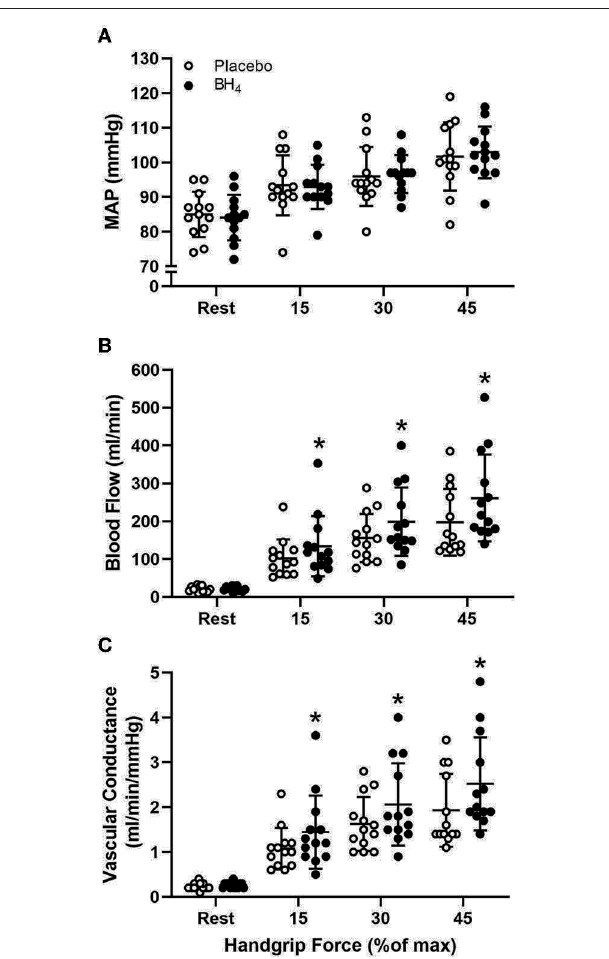
FIGURE 1 | Mean arterial pressure [MAP (A) ], brachial artery blood flow (B) , and brachial artery vascular conductance (C) at rest and during progressive handgrip exercise in patients with systemic sclerosis after placebo (white circles) and tetrahydrobiopterin (BH 4 ; black circles). * P < 0.05, significantly different than placebo. All data are presented as mean ± SD.